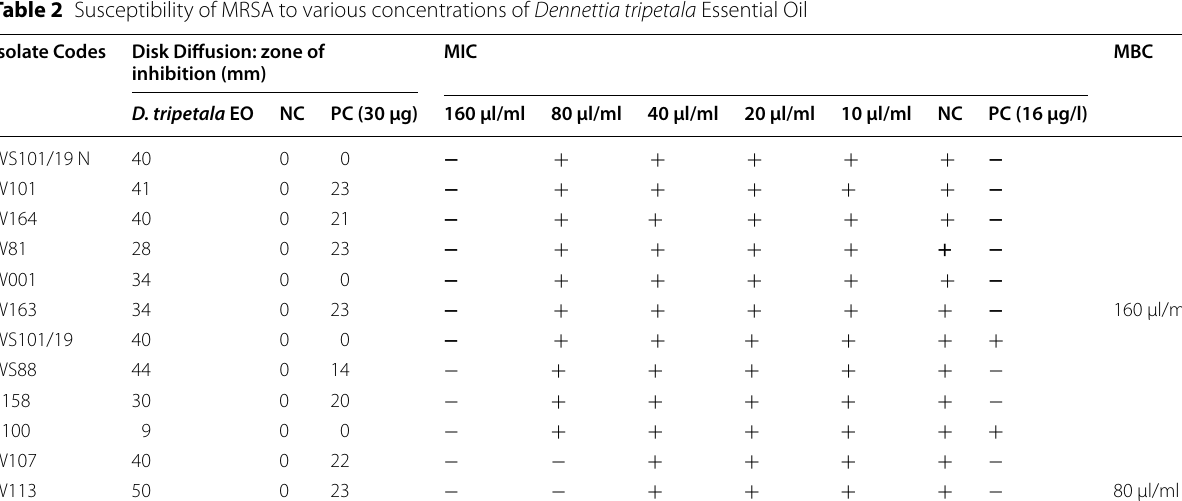
Fig. 2 Mass spectrum of the six identified compounds